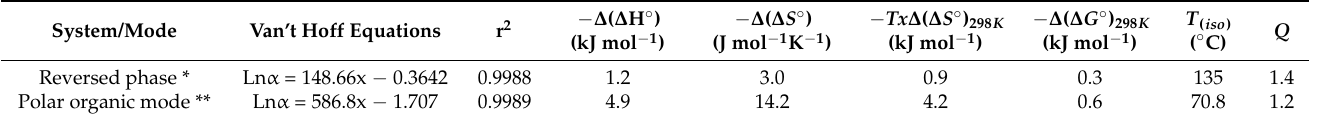
Table 4. Thermodynamic parameters, ∆ ( ∆ H ◦ ), ∆ ( ∆ S ◦ ), Tx ∆ ( ∆ S ◦ ), ∆ ( ∆ G ◦ ), Van’t Hoff equation, correlation coefficients and Q